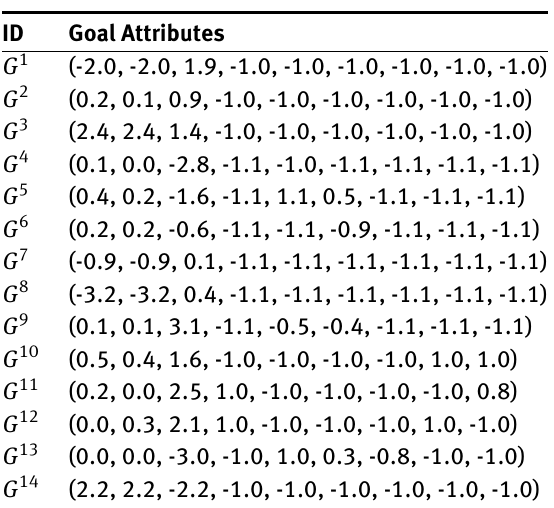
Table 4: Maintenance goal prototypes generated in the first run of experiment 2 with ρ M = 0.3. Weights are rounded to 1 decimal place.